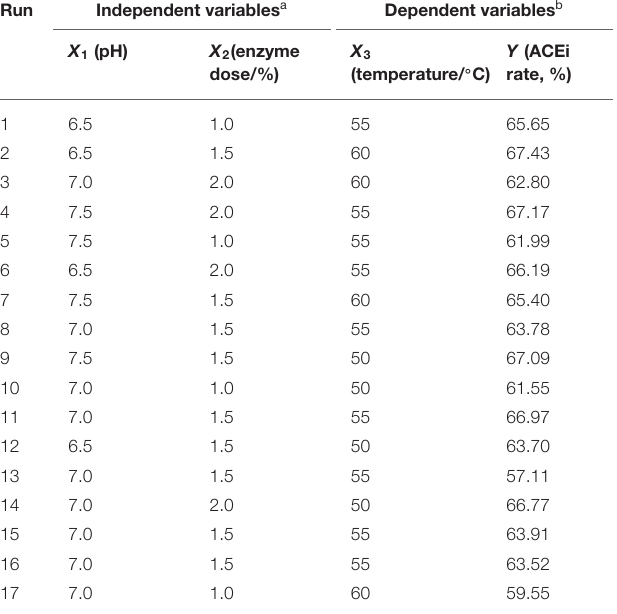
TABLE 1 | Box-Behnken design and experimental results of response surface methodology. Run